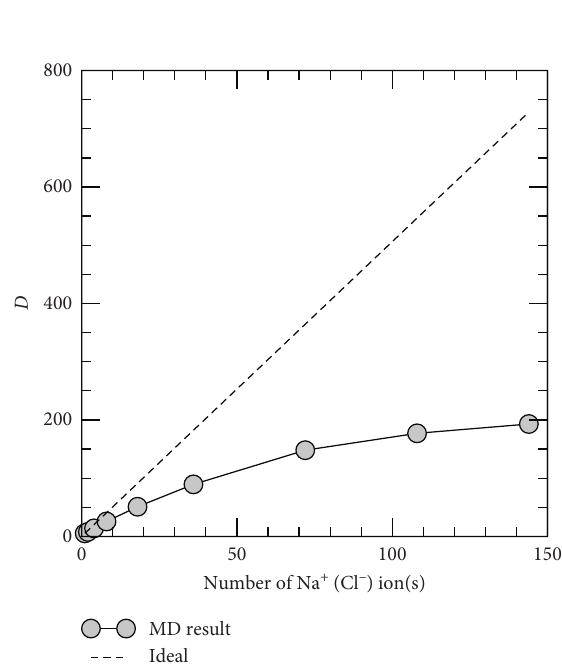
Figure 8: Sum of diffusion coefficients of all the ions in the systems. MD result: multiplied by n in DA1 to DA9 in Table 3 for systems A1 to A9 for κ � 0.10 ˚A − 1 and ideal: obtained from DA1 multiplied by n in Table 3 for all identical systems.